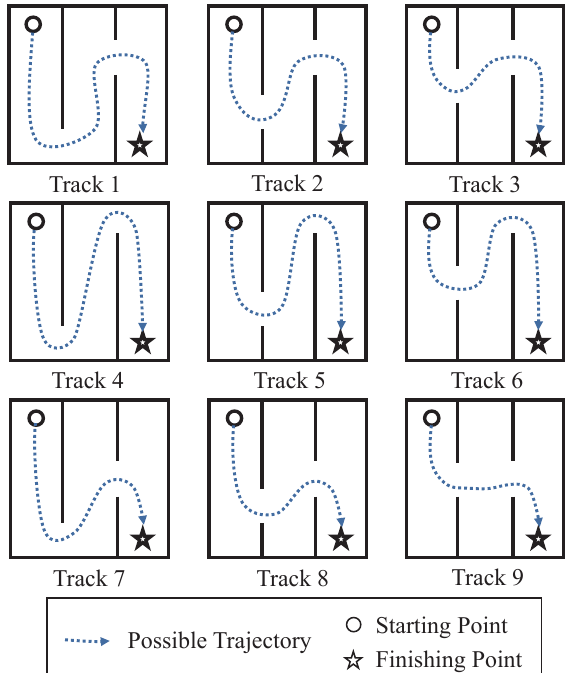
Figure 3. Schematics of the nine different tracks from which synchronized data have been collected. Dotted lines illustrate a typical robot